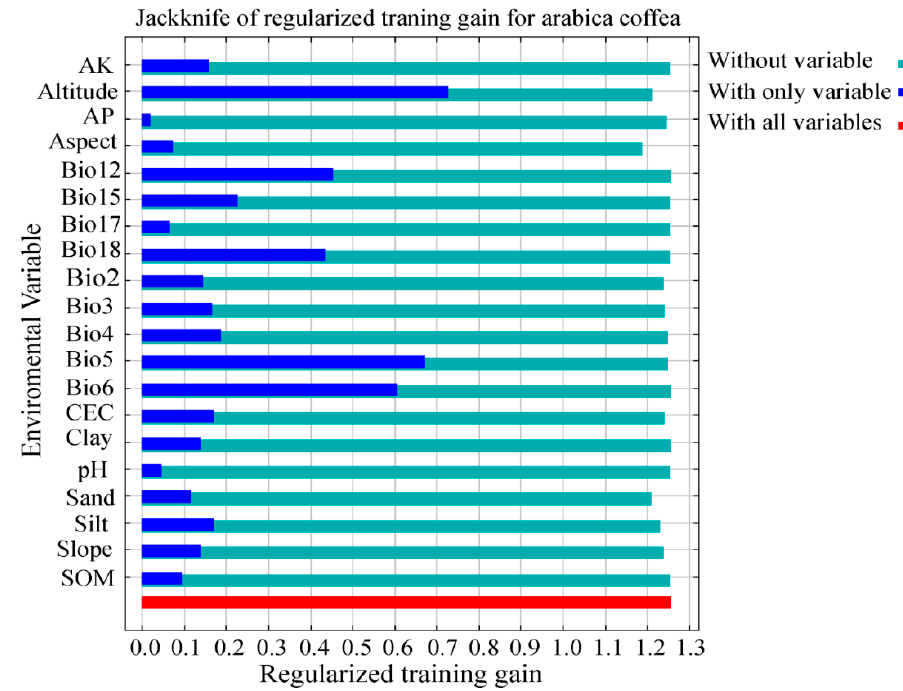
Figure 6. Jackknife results of habitat distribution predictions under current conditions.